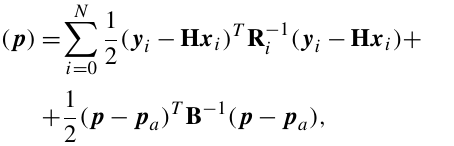
Figure 3. XCH 4 difference between GEOS-Chem and ACE-FTS due to the stratosphere, for GEOS-Chem at 4 ◦ × 5 ◦ (a) and at 2 ◦ × 2 . 5 ◦ (b) . The zonal mean difference for both model resolutions is shown in (c) . XCH 4 differences were obtained by augmenting the ACE-FTS stratospheric profile with the GEOS-Chem troposphere and smoothing the vertical CH 4 difference profile with the mean zonal GOSAT averaging